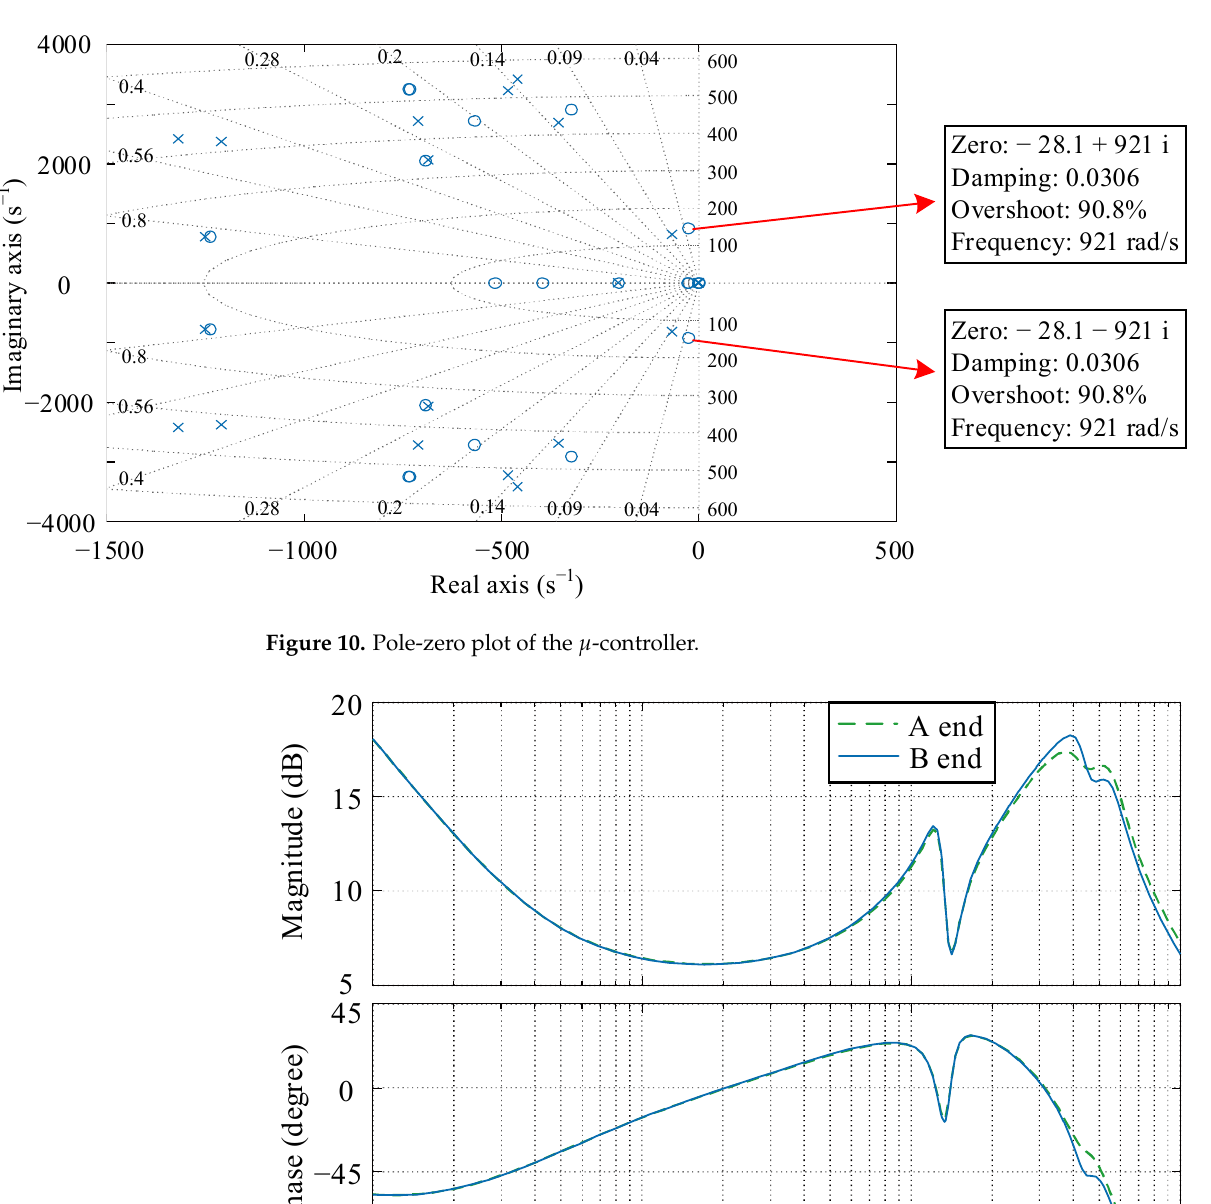
Figure 11. Bode diagram of the µ -controller. Additionally, the sensitivity function of the closed-loop system under the µ -controller with uncertain modal frequency is shown in Figure 12. The sensitivity peaks of the system at the A end and B end are 8.31 and 8.25 dB, respectively. Although the uncertainty exits, the µ -controller still has good performance and the sensitivity function falls within Zone A according to ISO 14839-3.